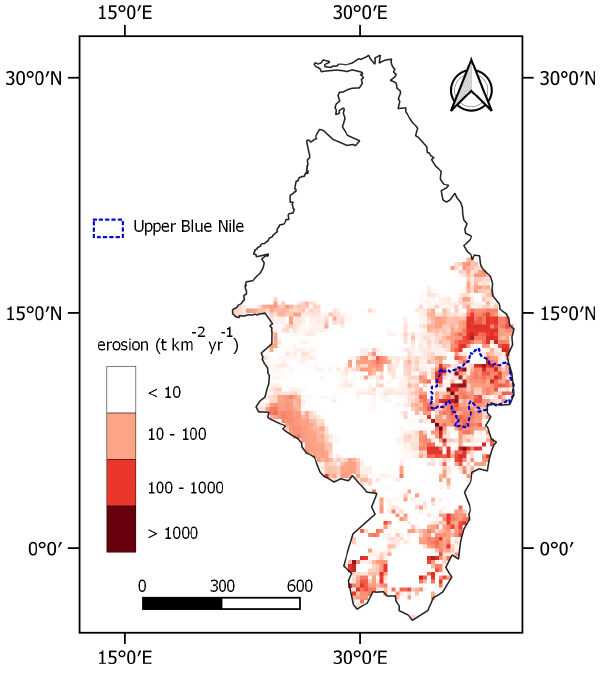
Figure 12. Spatial distribution of predicted annual average soil ero- sion at HRU level in northeastern Africa